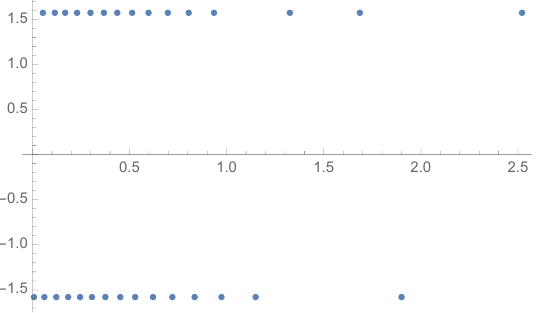
Figure 10 . Bethe roots for L = 32 corresponding to an excited state in the n = 2 sector with (cid:13) = (cid:25) . The Bethe numbers on the two lines are shifted by n 0 = 3 and n 1 = 1 5